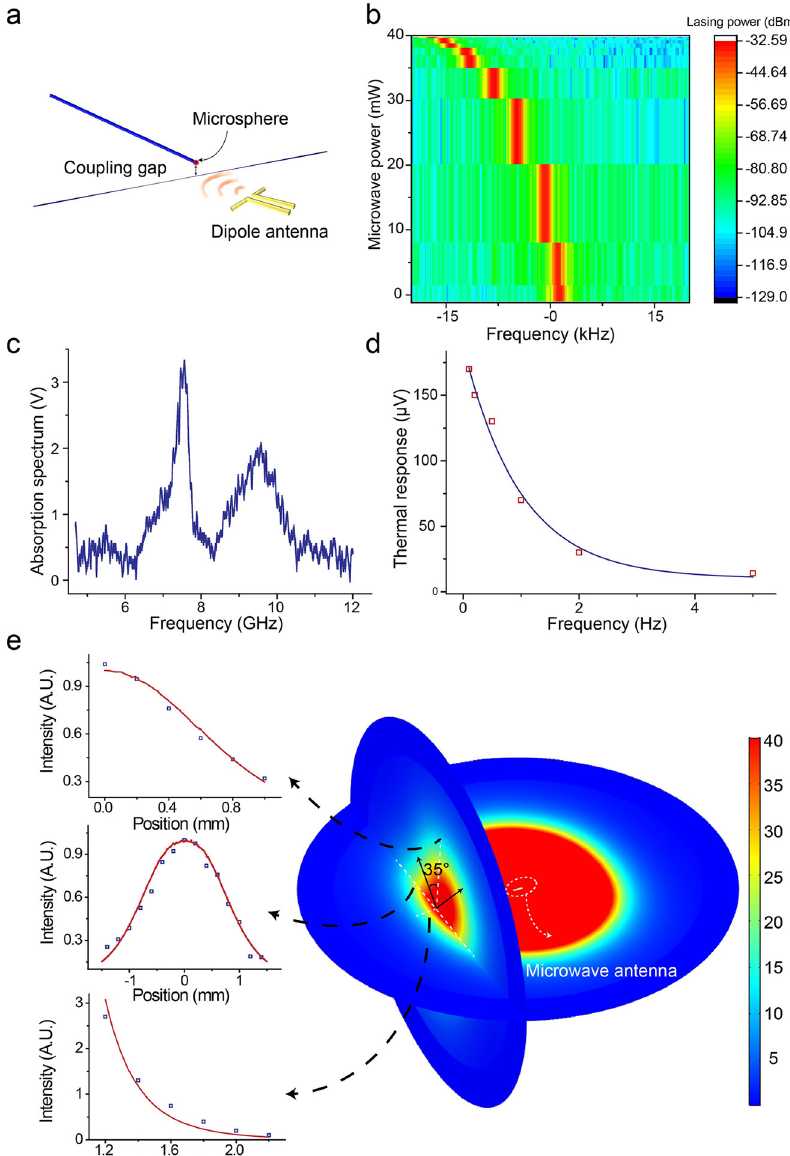
Demonstration of 3D microwave profile scanning. Right: FEM simulation of a microwave profile from a microwave antenna. The orientation of the dipole antenna is shown. The angle between the antenna plane and the vertical scanning axis is around 35 ° . Left: vertical, horizontal, and longitudinal microwave power distribution from top to bottom, respectively. The red lines are from FEM simulation and the blue squares are from experimental